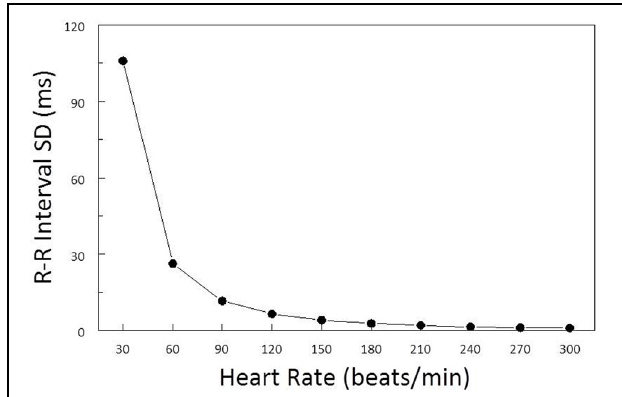
FIGURE 1 | Effect of baseline heart rate on heart rate variability. The standard deviation of R-R interval (RRSD) was calculated for a set of 5 simulated heart beats (X − 2, X − 1, X, X + 1, X + 2) over a range of mean heart rates (HR, from 30 to 300 beats/min) (solid black line). The standard deviation for HR was ± 1.6 beats/min at each HR level. Note that RRSD was inversely related to HR, identical changes in HR were accompanied by much larger R-R interval variability at low as compared to high prevailing